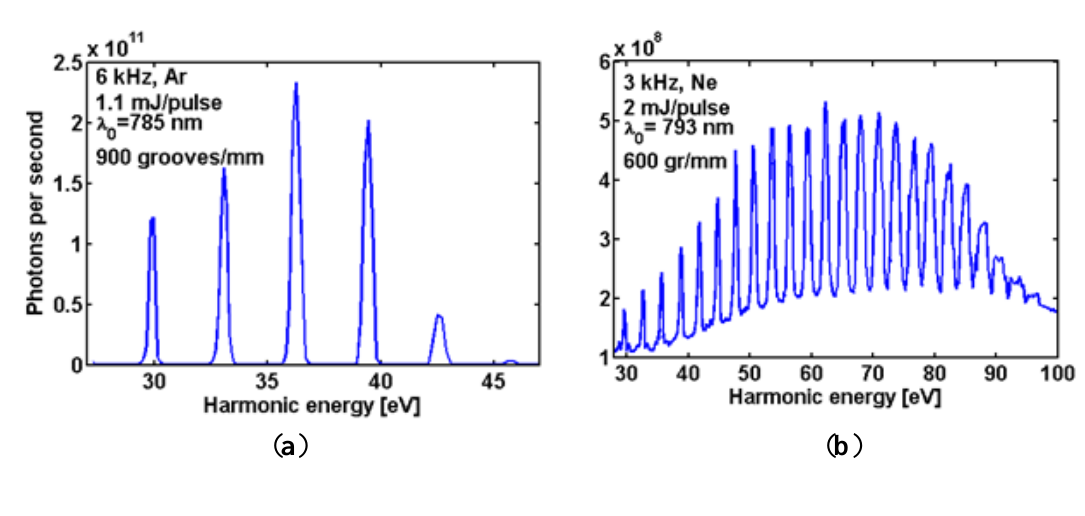
Figure 3. HH spectra scanned with the monochromator in argon ( a ) and neon ( b